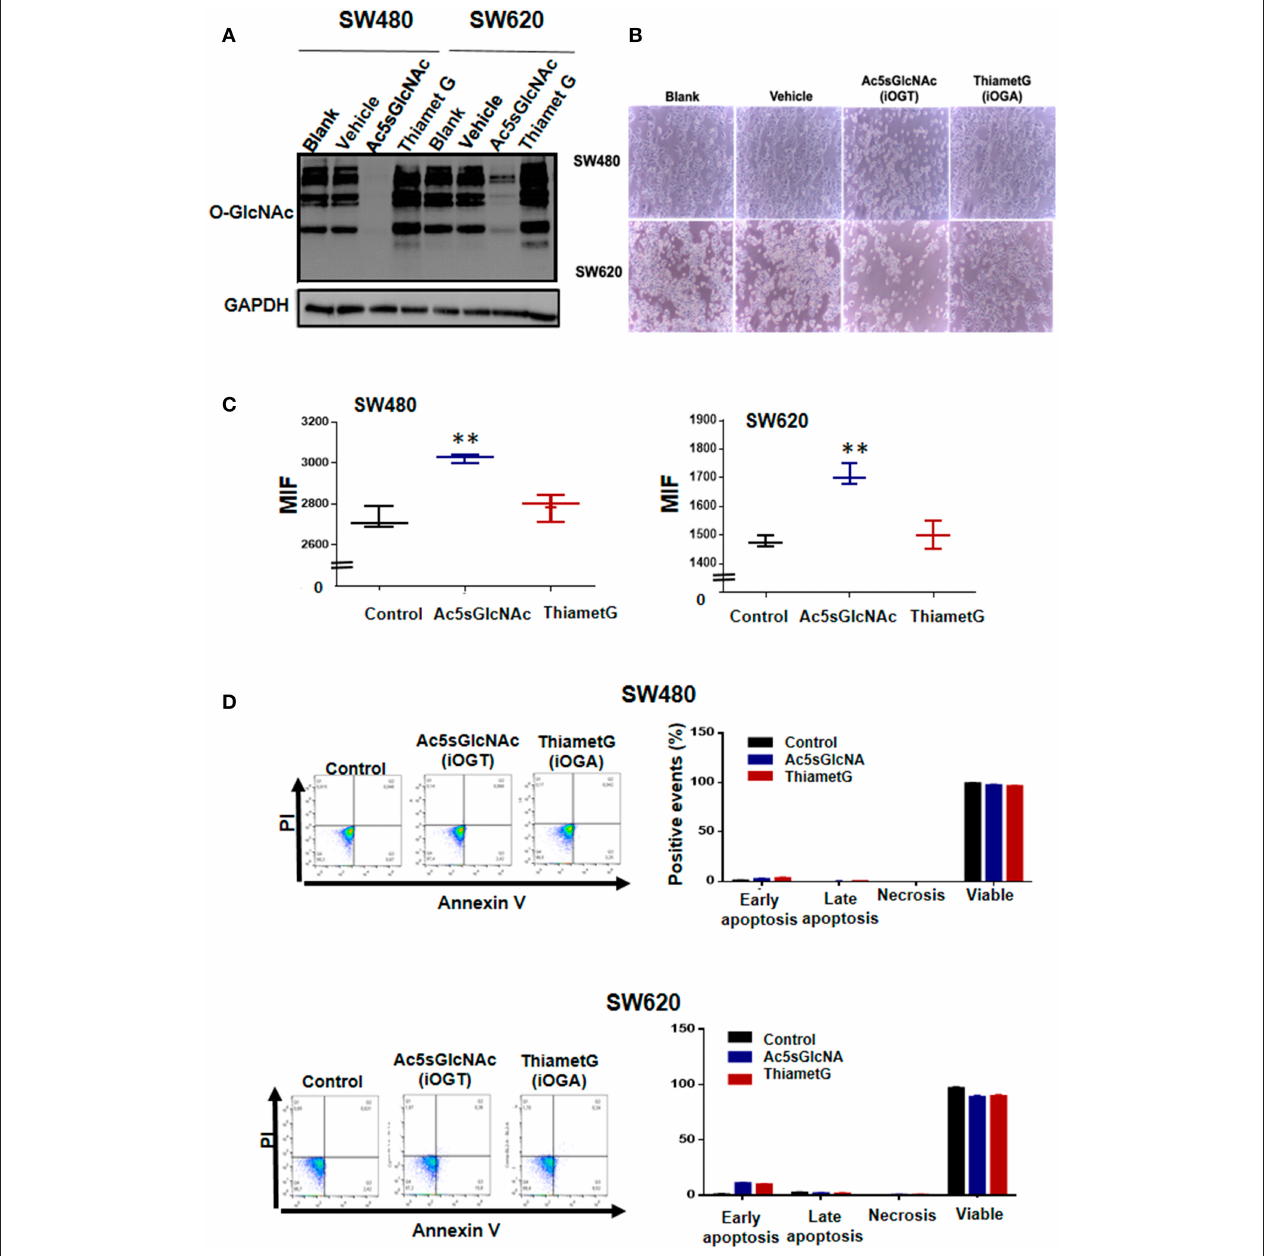
FIGURE 3 | Effects of the inhibition of OGT and OGA on the proliferation and apoptosis rates of SW480 and SW620 cells. Cells were incubated during 24h in the absence (vehicle) or presence of 50 µ M Ac5sGlcNAc to decrease the levels of O-GlcNAc, or in the absence (vehicle) or presence of 1 µ M Thiamet- G to inhibit OGA and increase them (A) Western blotting showing the effectiveness of the inhibitors on GlcNAc cellular levels. (B) After 24h, pictures of each treatment were taken with a light microscopy, augmentation 40X. (C) Proliferation assays were performed by flow cytometry with CellTrace CFSE. Data represent the means ± SEM from at least three independent assays ** p = 0.001 ( t -test) compared with control 112CoN cells. (D) Cell death was evaluated with the Annexin V-FITC Apoptosis Detection Kit. Dotplots show early, late, necrosis or viable cells. The data represent the means ± SEM from at least three independent assays.